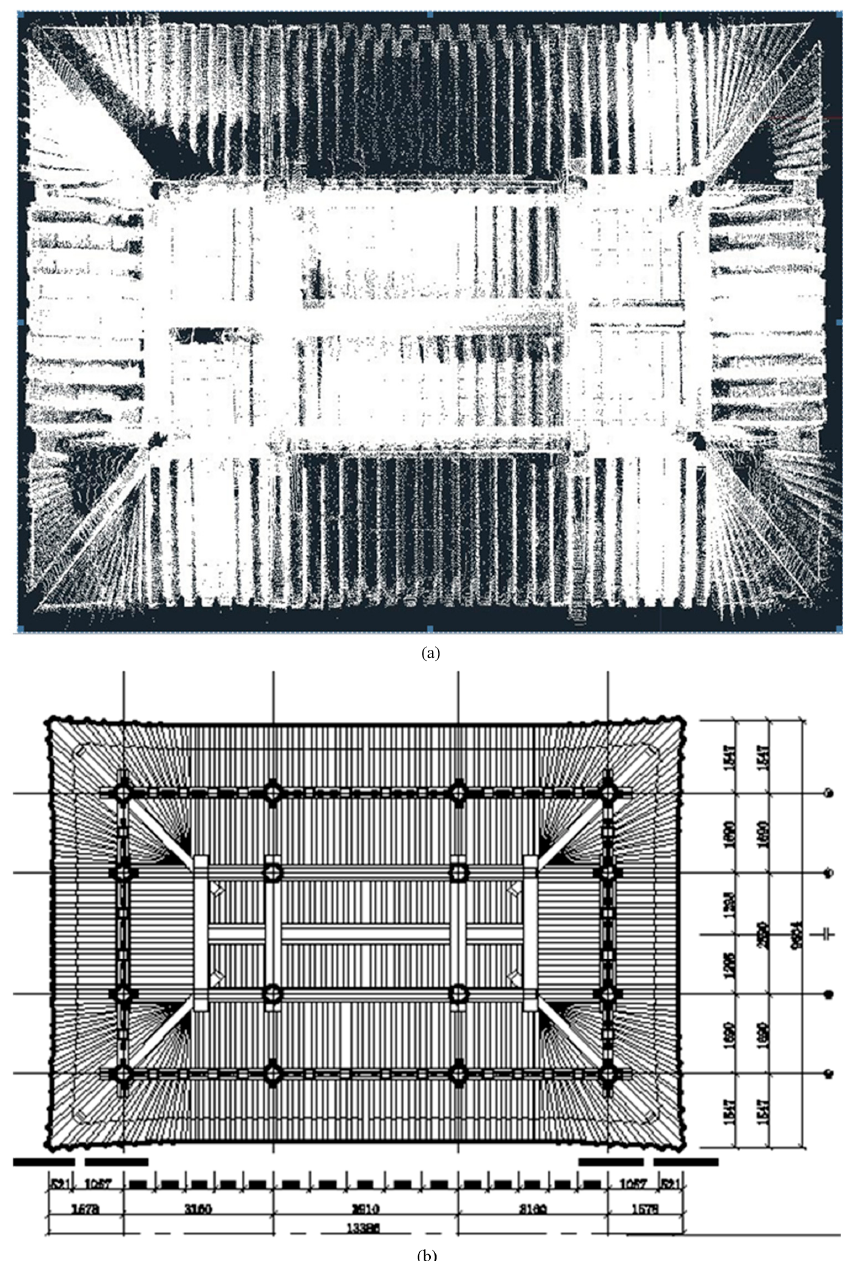
Figure 10. Point cloud projection for the plane drawing of the building roof. ( a ) Point cloud projection; ( b ) plane drawing based on point cloud projection.